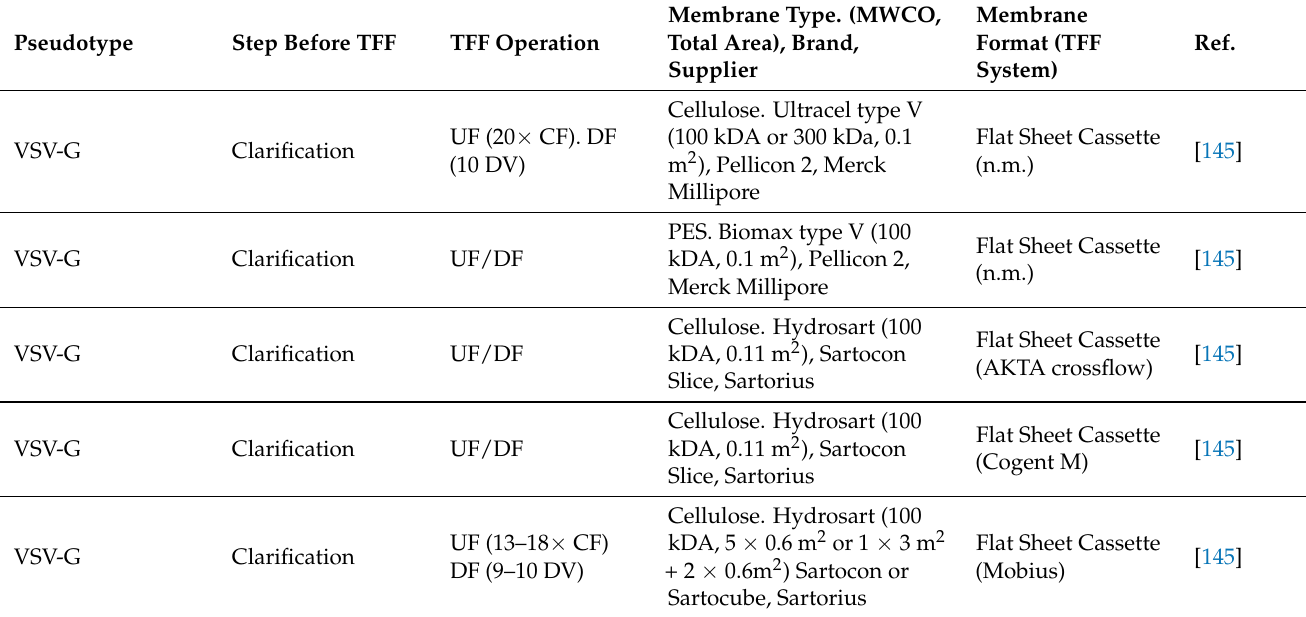
Table 7. Examples of tangential flow filtration operations and membrane materials in lentiviral vector processing.